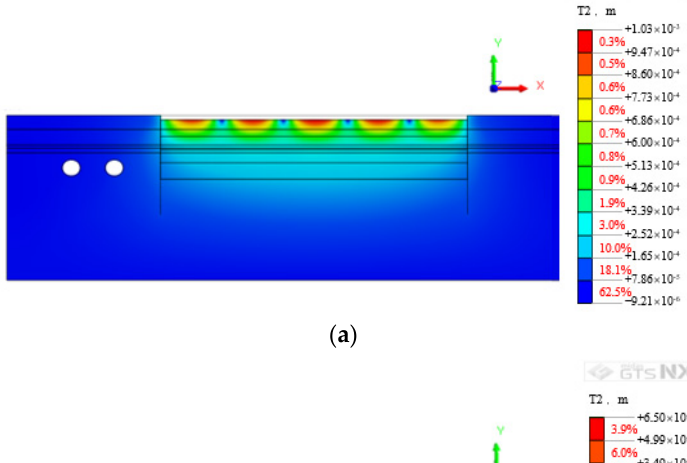
Figure 8. Vertical deformation caused by construction of section A. ( a ) Excavate to − 2.20 m ele- vation. ( b ) Excavate to the design elevation of the bottom of the foundation pit. ( c ) The inner supports on the fourth layer are removed. ( d ) All inner supports are removed.